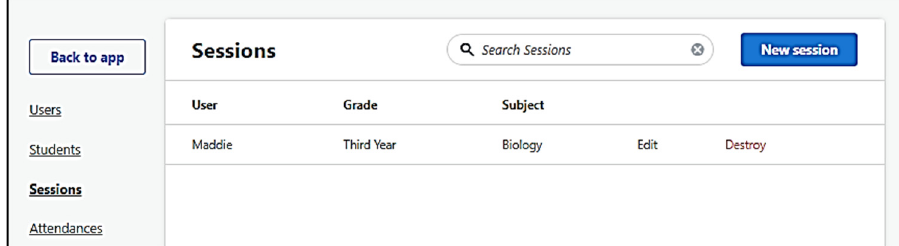
Figure 9. Application Dashboard Running on Heroku.